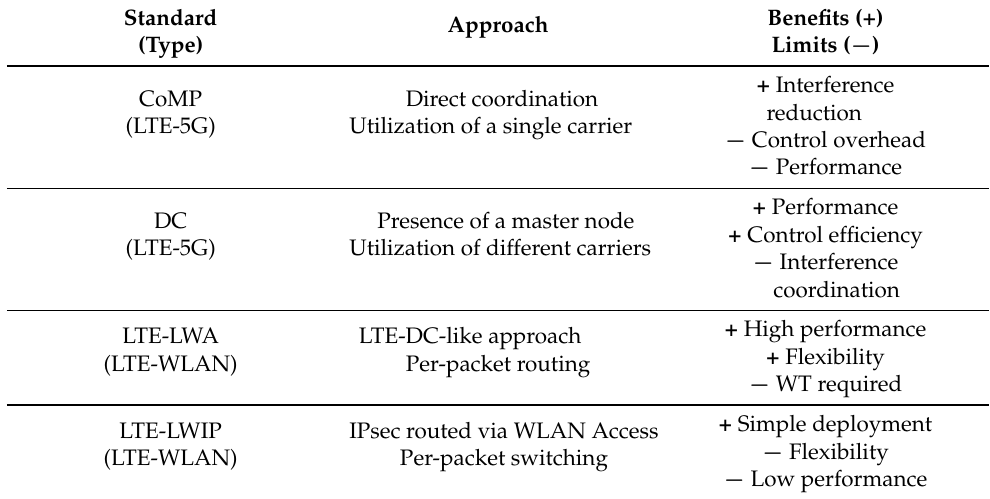
Table 1. Overview of existing standards for multi-connectivity in 5G networks and